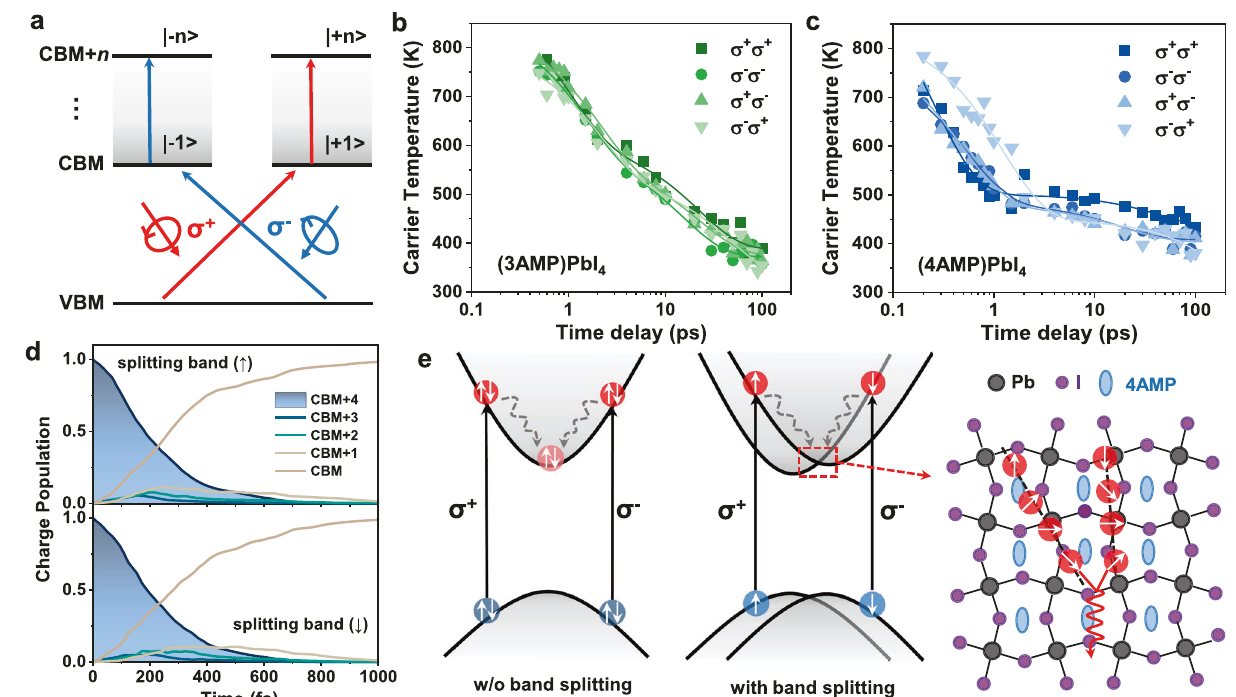
Fig. 4 Spin-selective hot carrier relaxation of 2D Dion – Jacobson perovskites. a Scheme for the optical selection for the circular polarized TA measurements of 2D DJ perovskite fi lms. Right (left) circular polarized light σ + ( σ − ) couples to the electronic transition from the valence bands to high- level conduction bands. Extracted hot-carrier temperature as a function of delay time of ( b ) (3AMP)PbI 4 and ( c ) (4AMP)PbI 4 obtained from